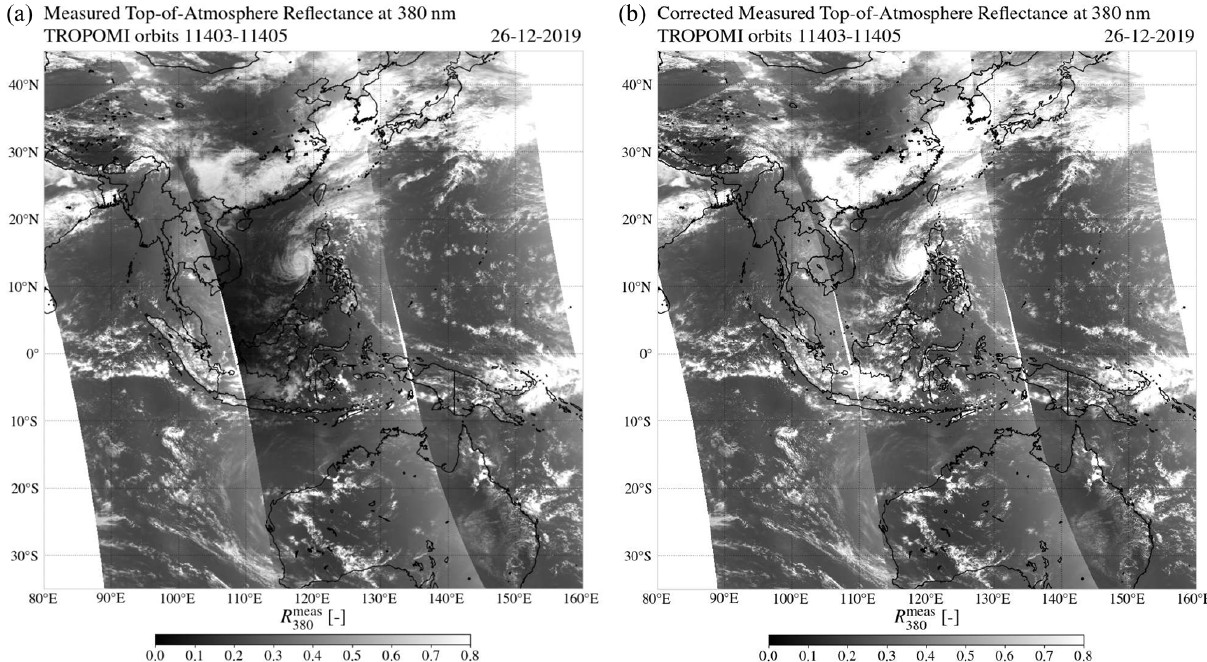
Figure 11. The measured top-of-atmosphere reflectance at 380nm by TROPOMI on 26 December 2019 at Southeast Asia in orbits 11403– 11405, uncorrected (a) and after the solar irradiance correction (b) .